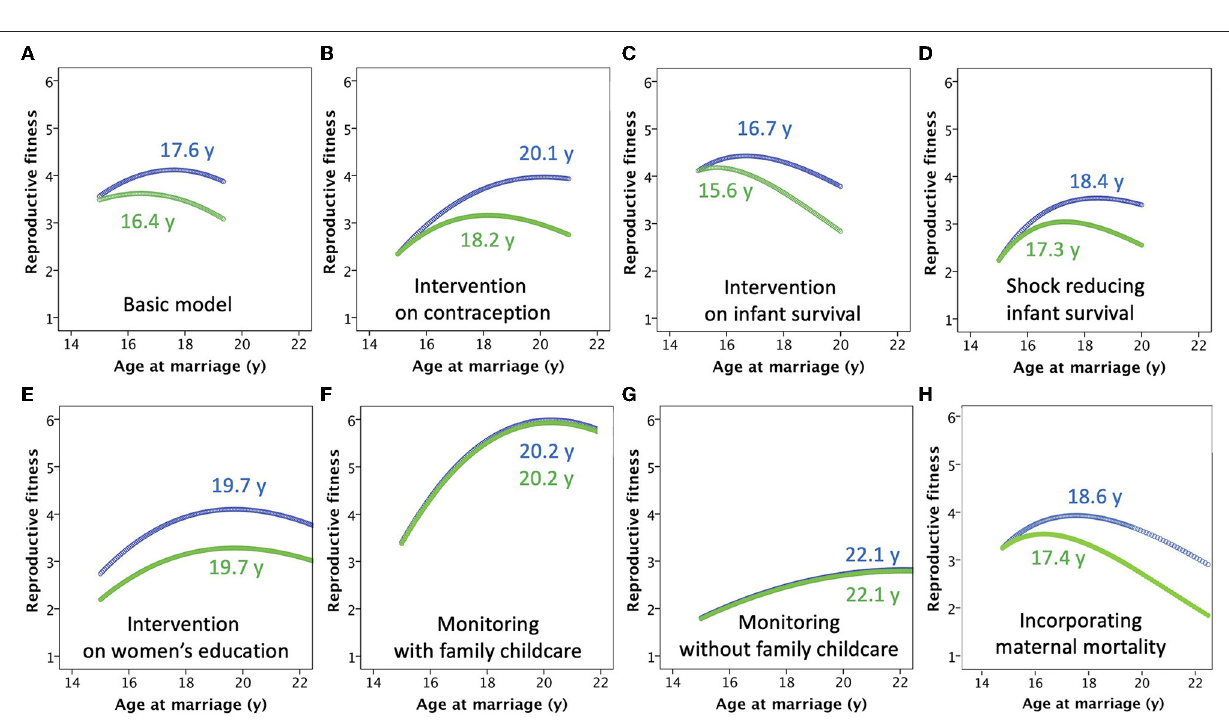
FIGURE 5 | Results of the models, with supporting numeric values given in Table 1 . (A) The basic model. (B) The model incorporating a “contraception” intervention, which standardizes the inter-birth interval at 3 years. (C) The model incorporating a public health intervention that reduces child mortality risk by 10%. (D) The model incorporating an economic shock that increases child mortality by 20%. (E) The model incorporating an intervention to increase women’s education, which simultaneously reduces mortality risk, while increasing both the inter-birth interval and paternity uncertainty. (F) The model incorporating “monitoring” by the marital household of the mother, which reduces the inter-birth to 2 years and increases child mortality risk, while minimizing paternity uncertainty. The marital household compensates for suppression of maternal autonomy by taking on responsibility for providing medical care for the children (G) The model incorporating “monitoring” by the marital household of the mother, similar to the previous scenario but where compensatory support by other household members is not provided. (H) The model incorporating a declining risk of maternal mortality with increasing age at marriage, due to later onset of reproduction and longer inter-birth